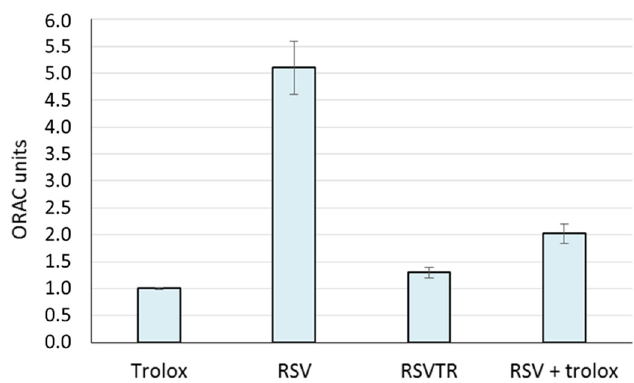
Figure 7. Oxygen Radical Absorbance Capacity (ORAC) units of trolox, resveratrol (RSV), resveratrol triester with trolox (RSVTR) and a physical mixture of RSV and trolox in the same molar ratio of RSVTR (RSV + trolox).